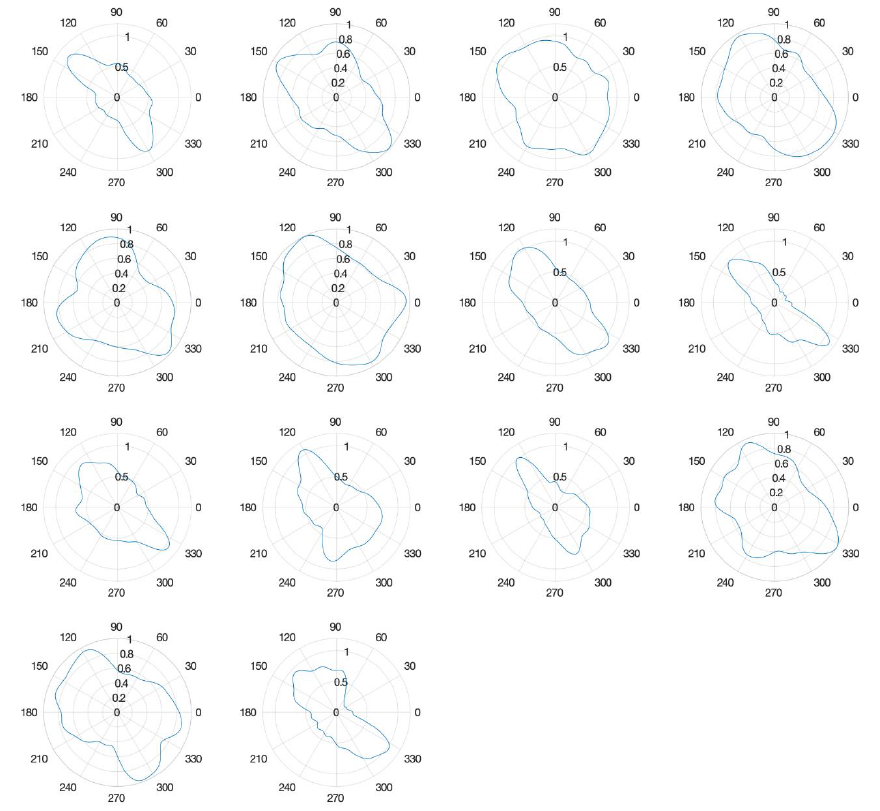
Figure 6. An example of random aggregate shapes is obtained from Section 3.2. These aggregates are aligned as an array according to the cluster number (G) they belong to: clusters 1 to 4 (top row), 5 to 8 (2nd row), 9 to 12 (3rd row), and 13 to 14 (last row).